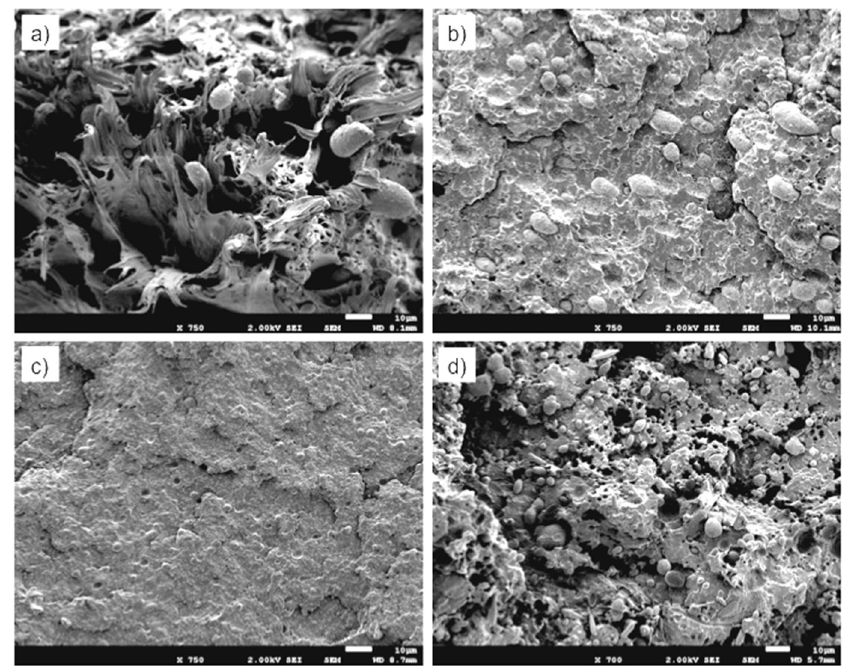
Figure 15. SEM micrographs of the fracture process zone after tensile tests of PBNANO-0 ( a ) PBNANO-hpho ( b ), PBNANO-hphoM ( c ) PBNANO-hphi ( d